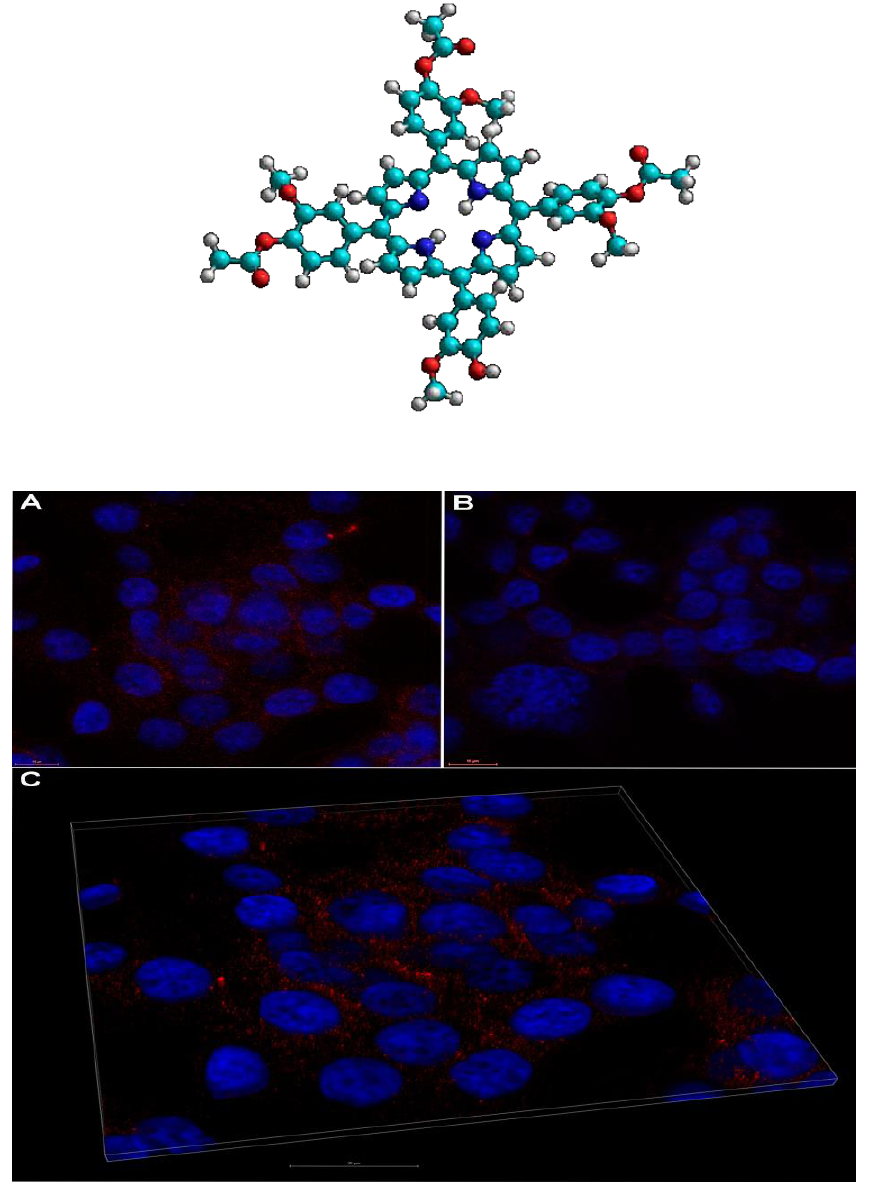
Figure 5. Representative laser scanning microscopy image of 5-(4-hydroxy-3-methoxyphenyl)- 10,15,20 – tris(4-acetoxy-3-methoxyphenyl) porphyrin (10µM) uptake by human HT-29 colon car- cinoma cells: ( A ): porphyrin (red) scattered throughout cytosol compared to control ( B ); ( C ): 3D volume rendering of 2.36 μm z -stack from A; nuclei were stained with DAPI (blue); scale bar 10 μm in ( A ),( B ) and 20 μm in ( C ) [160].